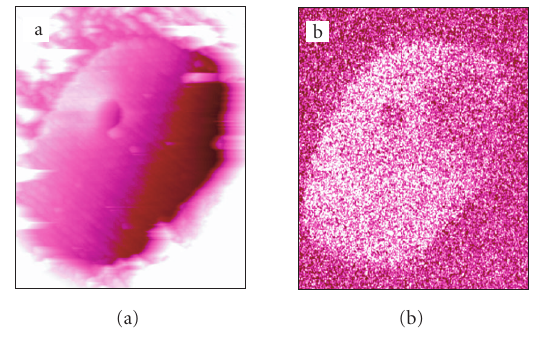
Figure 41: Simultaneous shear-force AFM (a) (25 μ m, Z range 5 μ m) and fluorescence SNOM (b) of a microtome cut surface of an evenly dyed polyester fiber (dye 13 ) in Technovit 7100.